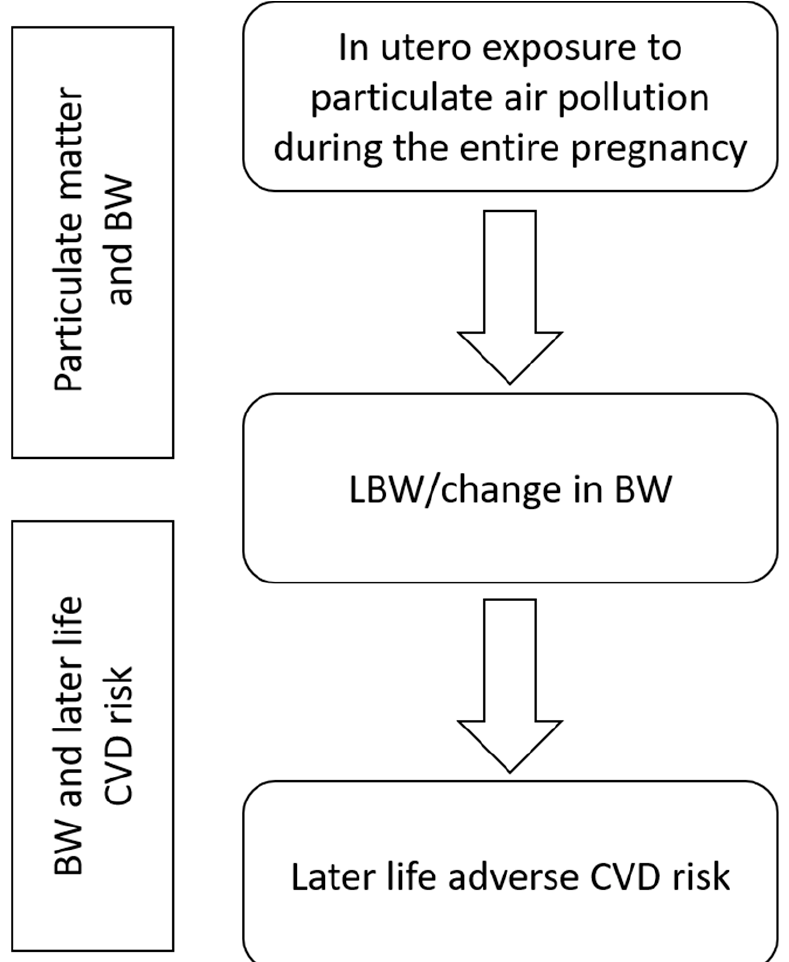
Figure 1. Schematic display of the structure of this review. In a first step, the impact of in utero particulate matter (PM) exposure on birth weight (BW) is assessed, and in a second step, the impact of low or lower birth weight (LBW) on later life cardiovascular disease (CVD)